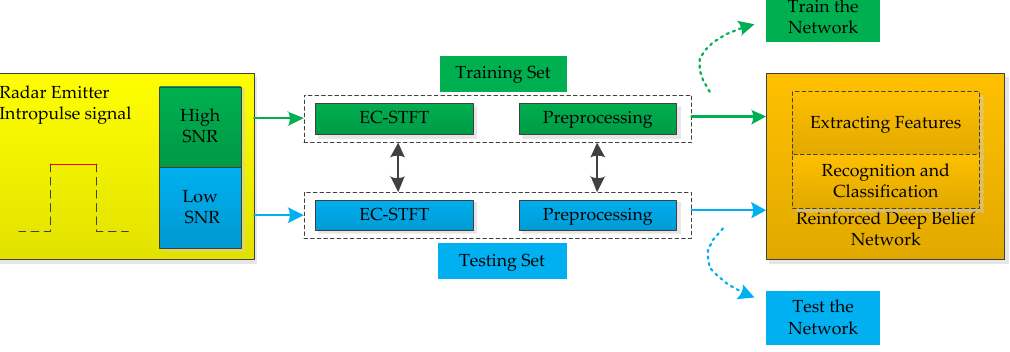
Figure 1. Framework of the radar emitter recognition in this work.